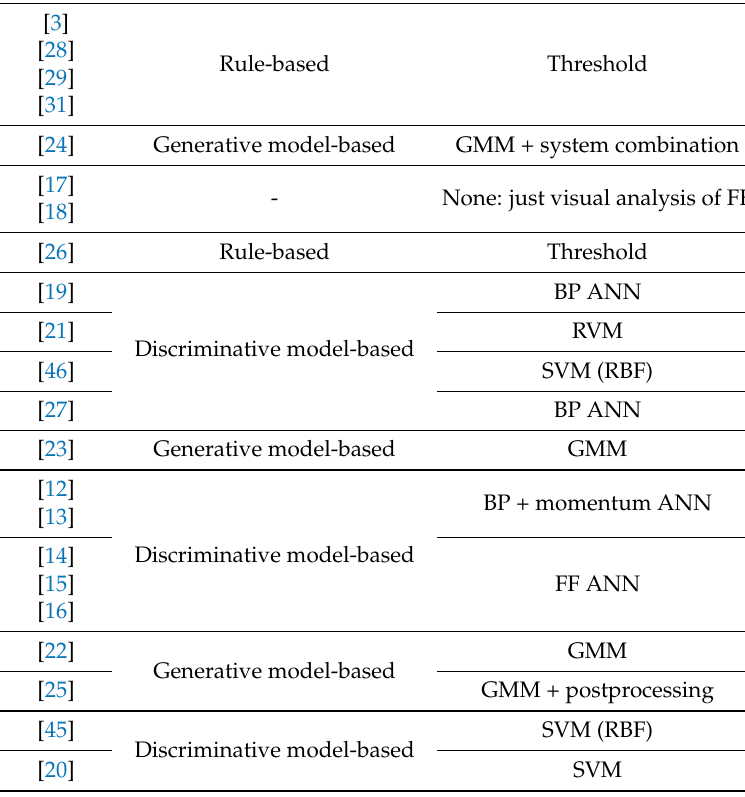
Table 8. Summary of the pattern classification approaches reported in the literature for DOFS+PRS. ‘GMM’ stands for gaussian mixture model, ‘BP’ for backpropagation, ‘ANN’ for artificial neural network, ‘RVM’ for relevance vector machine, ‘SVM’ for support vector machine, ‘RBF’ for radial basis function, ‘FF’ for feedforward, and ‘FE’ for feature